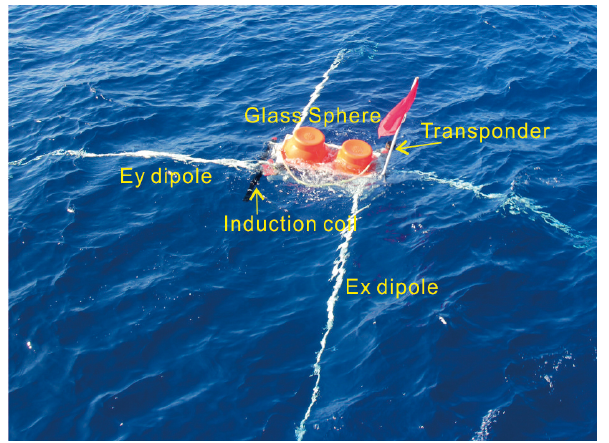
Figure 2. Photograph of the OBEMS while in the water ascending to the surface after release. The length of the electrode dipole is